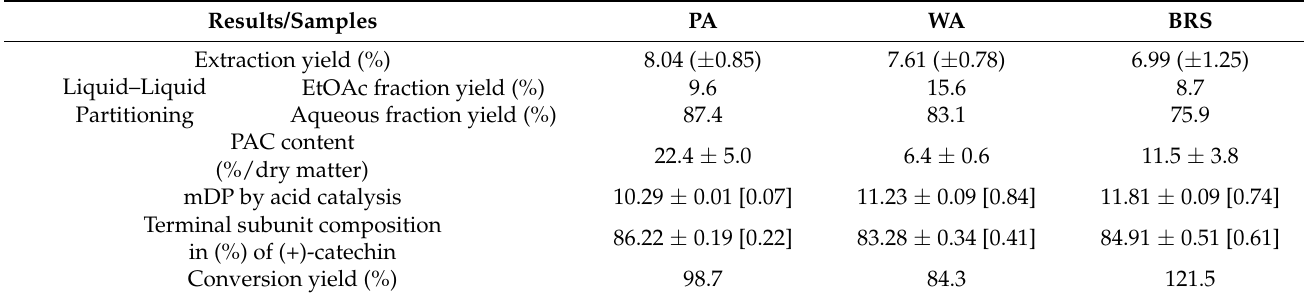
Table 1. Extraction, liquid–liquid partition, mDP, and n-BuOH/HCl result from PA, WA, and BRS samples.